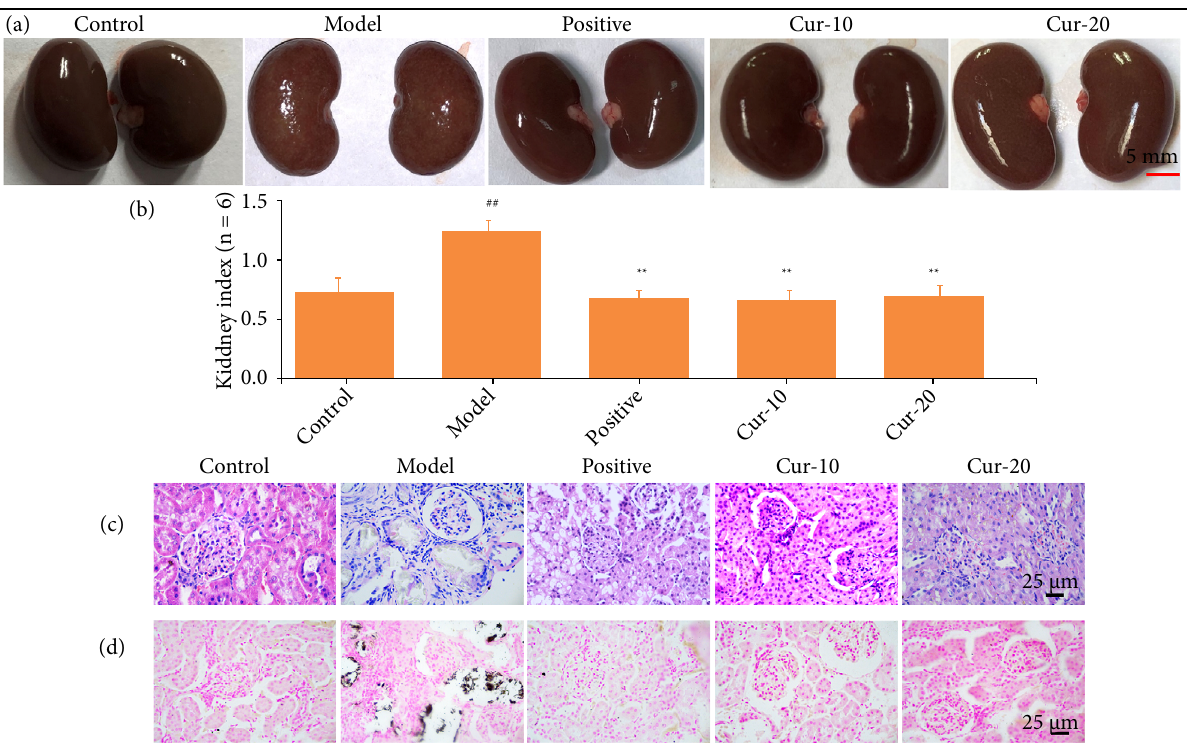
Figure 1 – Curcumin reduces EG-induced calcium oxalate deposition. (a) Photographies of rat kidneys in each group. The kidney surface of the control was smooth without particle sensation, the kidney surface of the model was swollen, accompanied by stone like particles; (b) Kidney index (n = 6), ** P < 0.01 means comparison with model group, ## P < 0.01 means comparison with the control group. (c) HE staining results of kidney tissue, the black part indicates kidney stone; (d) von Kossa staining result of kidney tissue, the black part indicates calcium deposition. Their magnification is 400